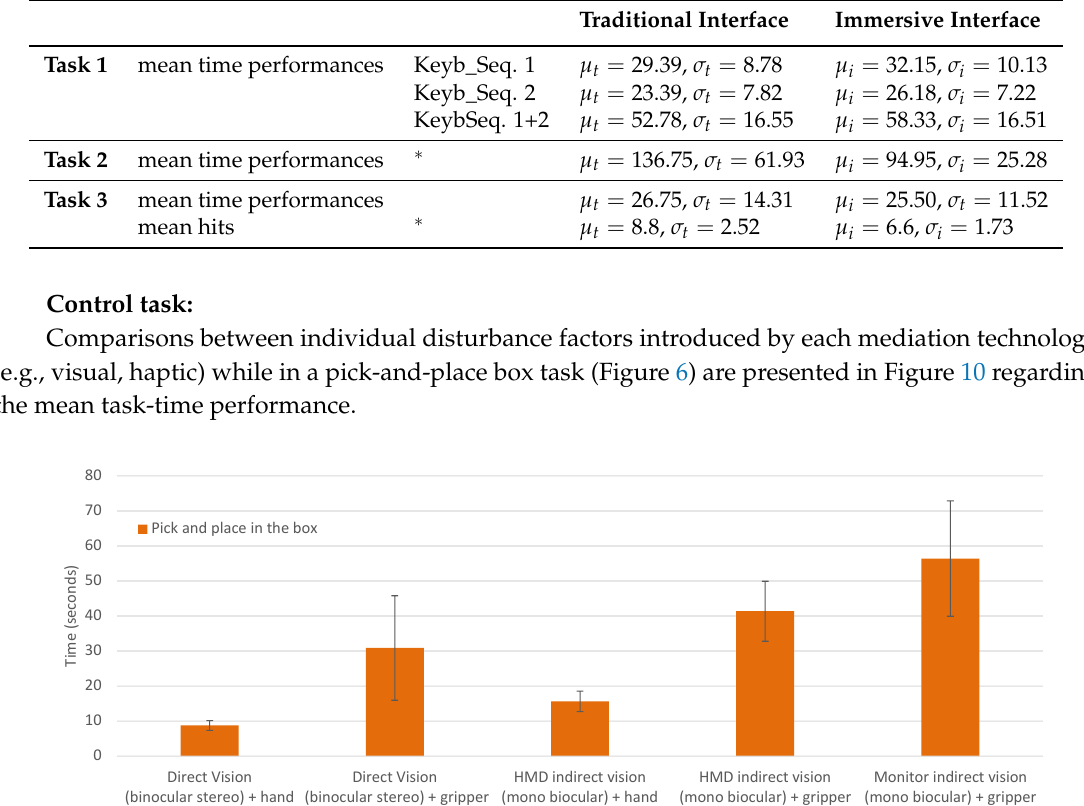
Figure 10. Mean task-time performance: pick and place in the box task. Comparison of individual disturbance factors introduced by each mediation technology (visual, haptic, shift between kinesthetic and visual